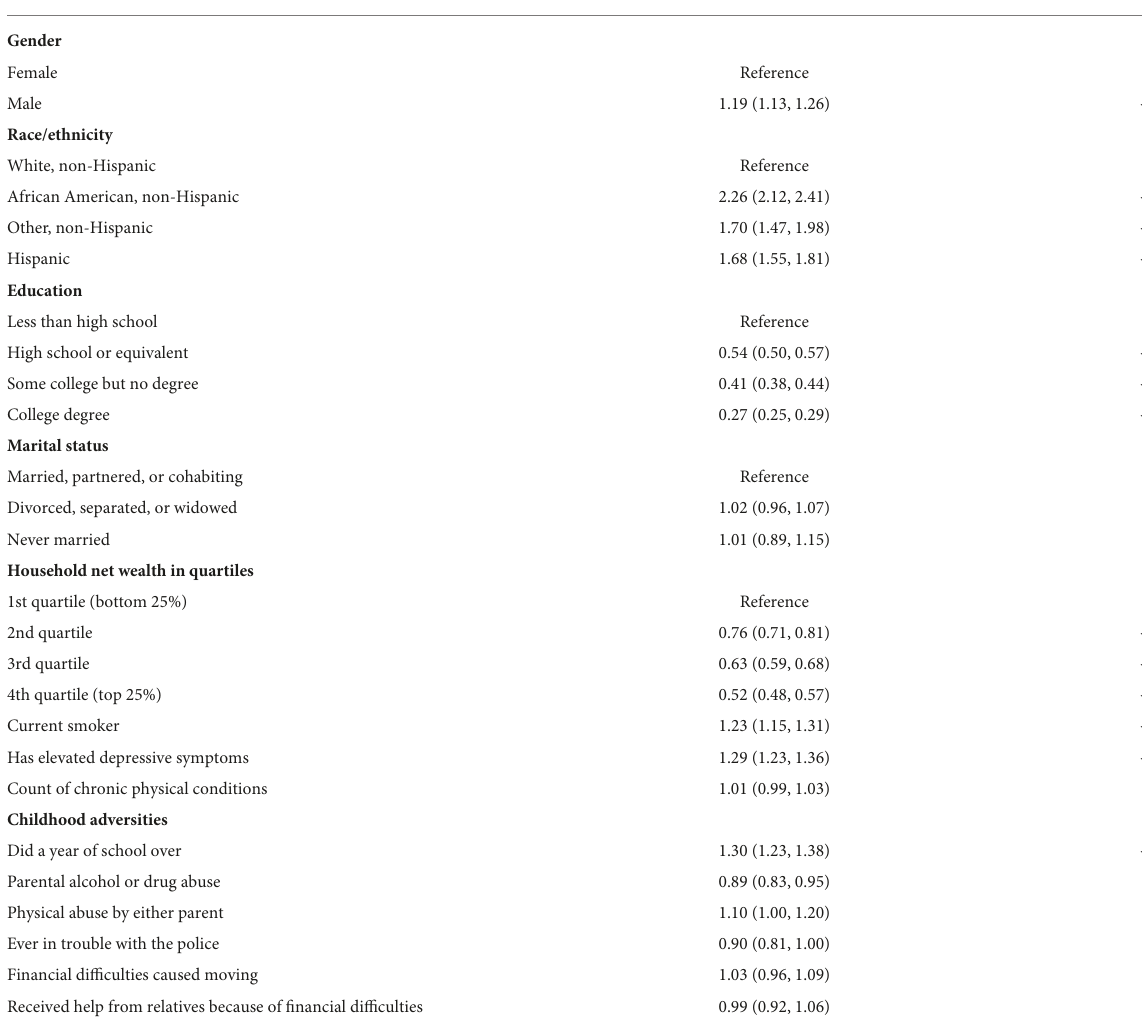
TABLE 3 Results from Cox proportional hazard model on cognitive